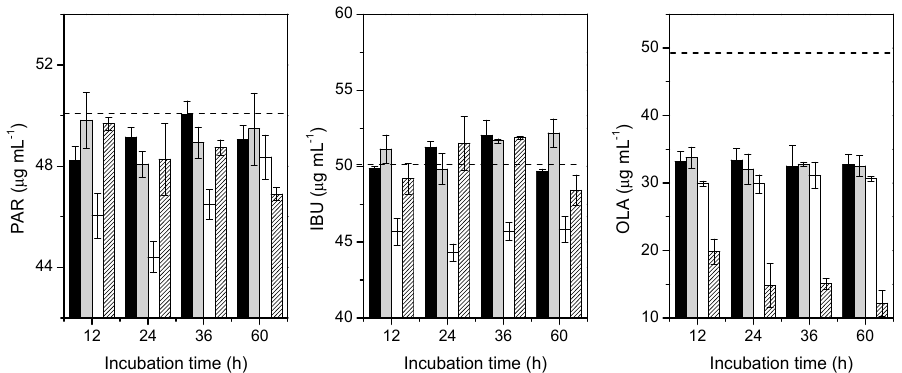
Figure 6. PAR, IBU and OLA removal by Nannochloropsis sp. in continuous cultures for 60 h. f/2 medium (black), Beads (gray), Immobilized (white) and Free cells (black lines). Horizontal dashed lines represent the concentration at t = 0. The chromatogram shows an overestimated determination for IBU concentrations that corresponds to expected fluctuations in the measurements (the error in the concentration determination is around 4%). Bars represent the SD.